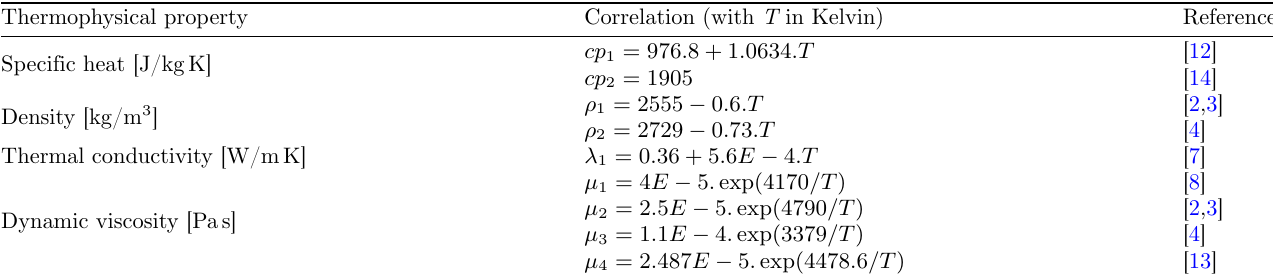
Table 1. Correlations for thermophysical properties of FLiNaK taken from